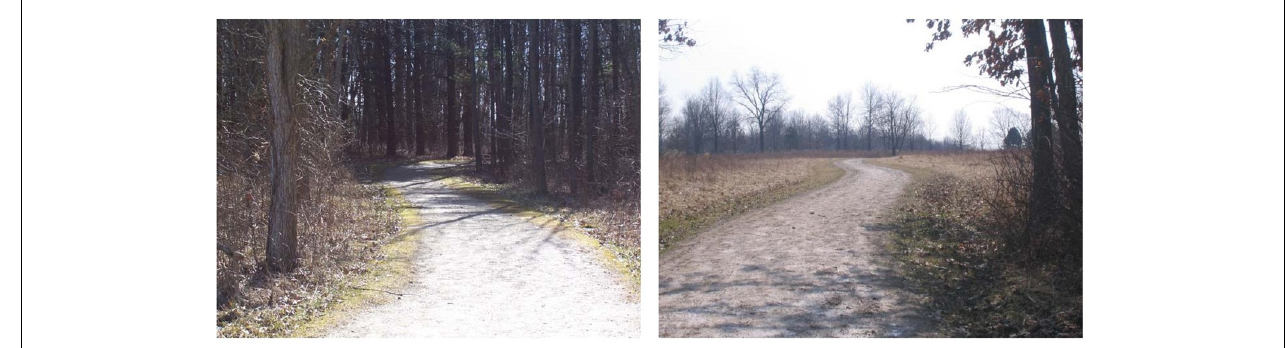
FIGURE 1 | Example of the high-mystery (Left) and low-mystery (Right) images used in the current study (from Szolosi et al.,